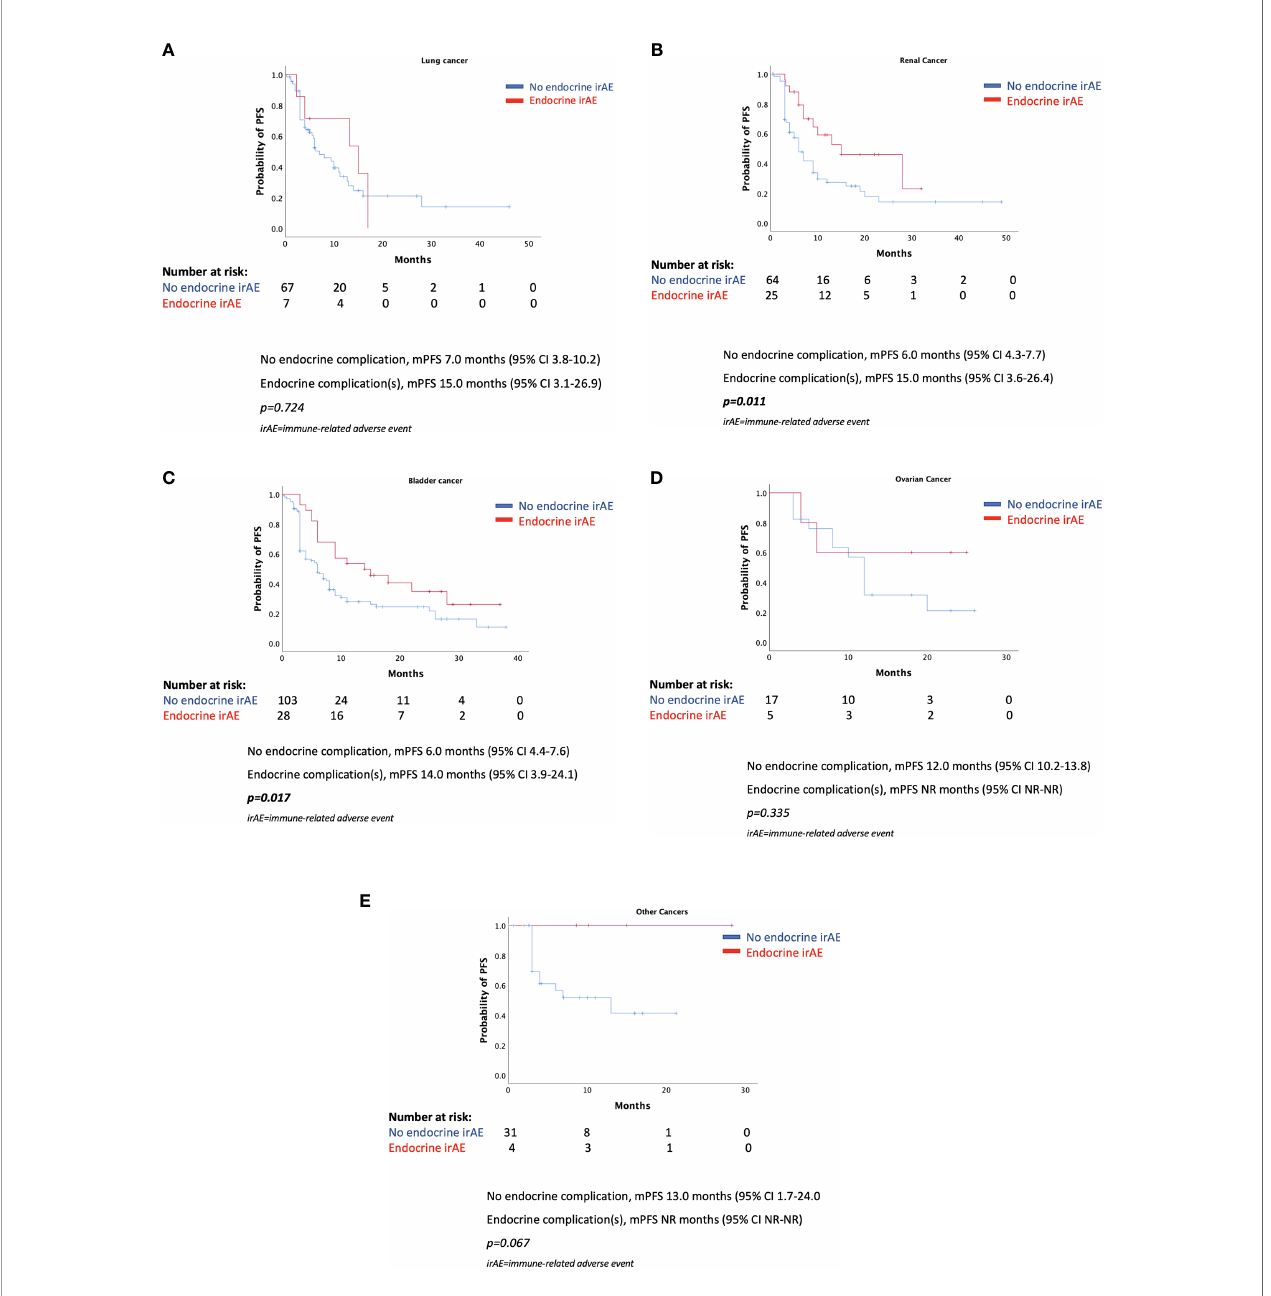
FIGURE 4 | (A – E) Progression-free survival according to the presence of endocrine complications by cancer